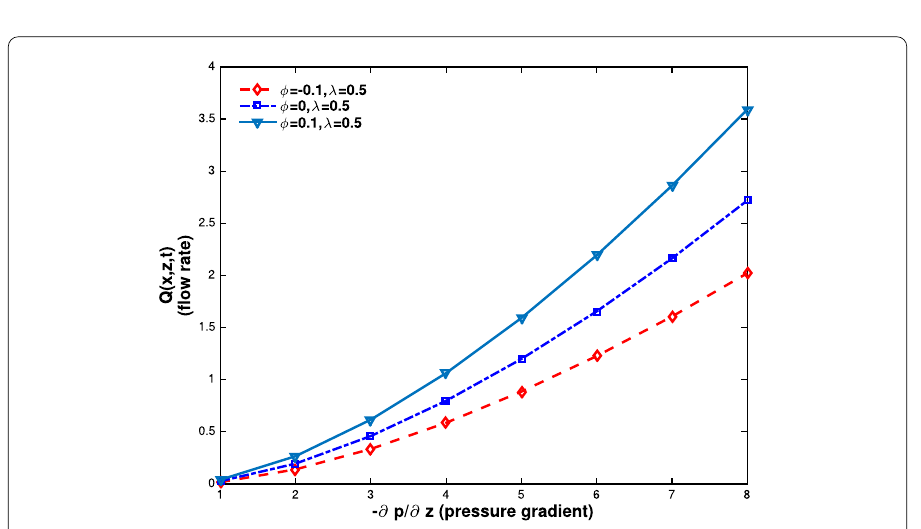
Figure 21 Flow rate vs pressure gradient for φ = –0.1,0,0.1 at z = 28, t = 0.45, τ y = 0.4, K = 1.6, λ =